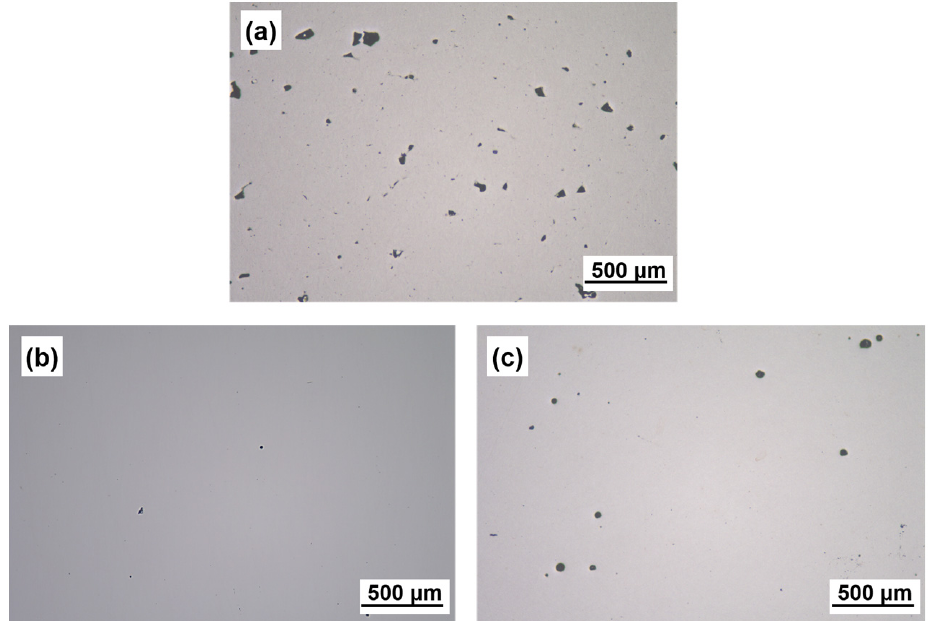
Figure 3. OM morphologies of samples with different VED: ( a ) 43.8 J/mm 3 ; ( b ) 60.0 J/mm 3 ; ( c ) 84.4 J/mm 3 .